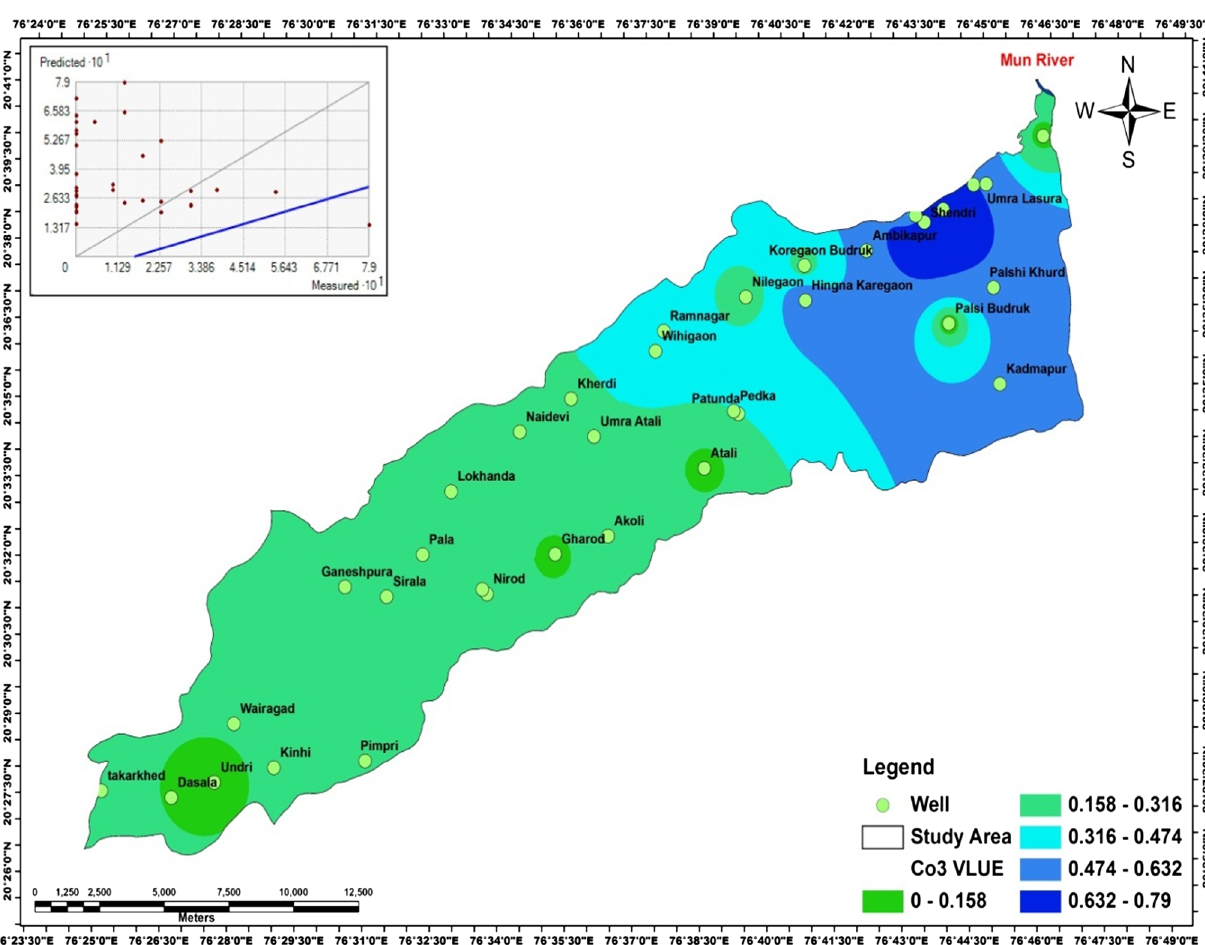
Fig. 13 Spatial distribution map of Co